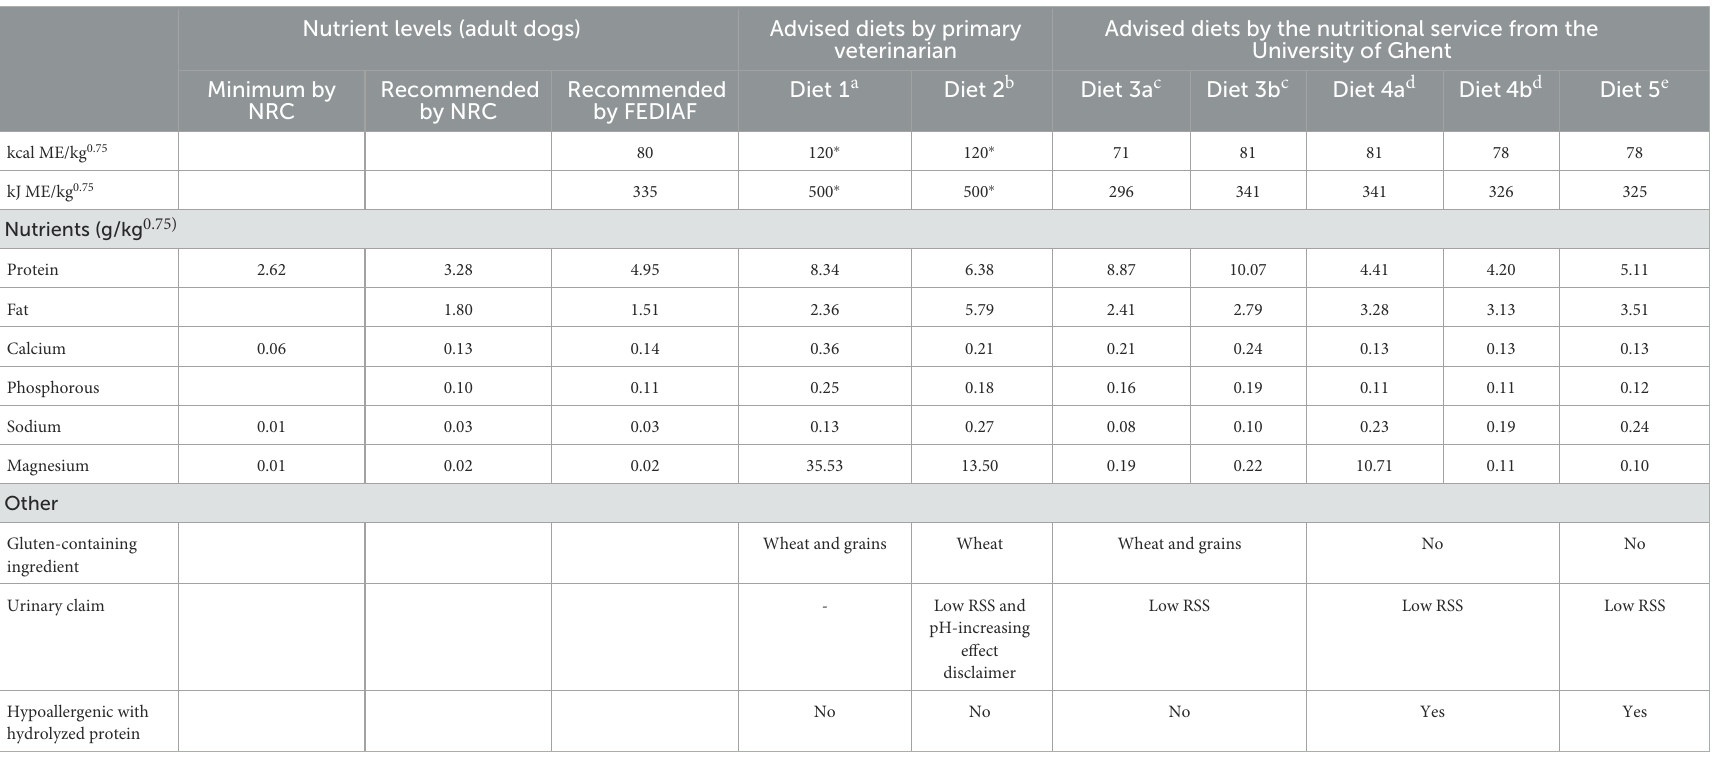
TABLE 1 Comparison between key nutrients (expressed in g/kg 0.75 ) and ingredients of the patient’s diets throughout its